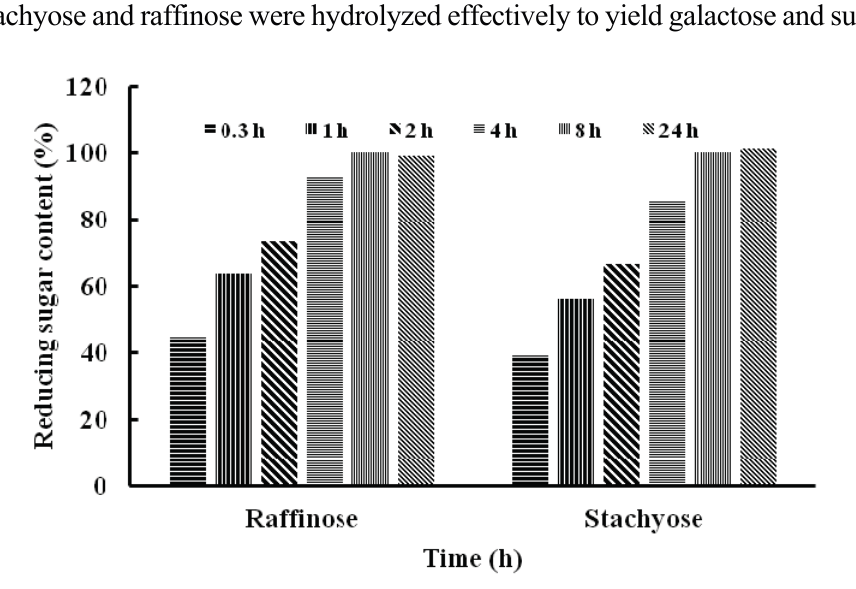
Figure 4. The content of reducing sugar after hydrolysis of raffinose and stachyose by Tricholoma matsutake α